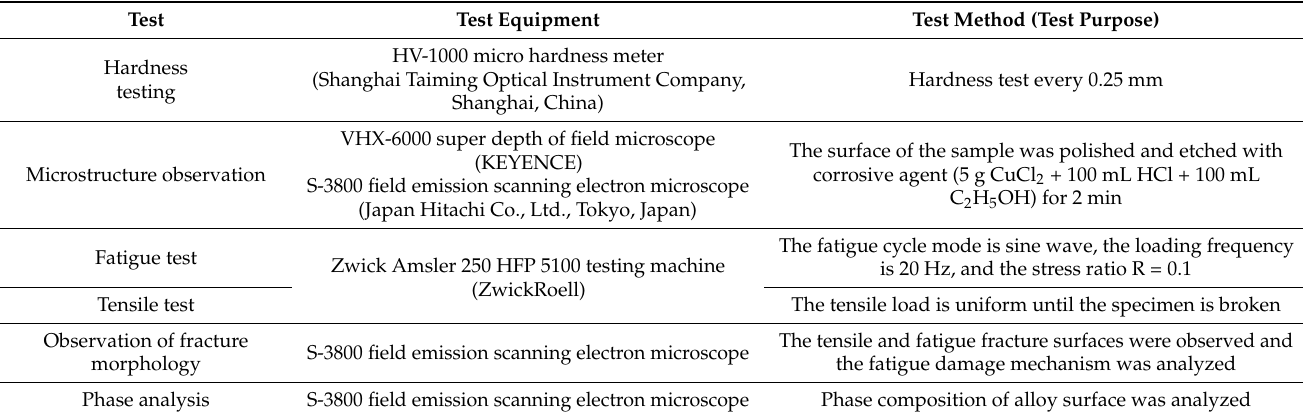
Table 2. Test, test equipment, and test